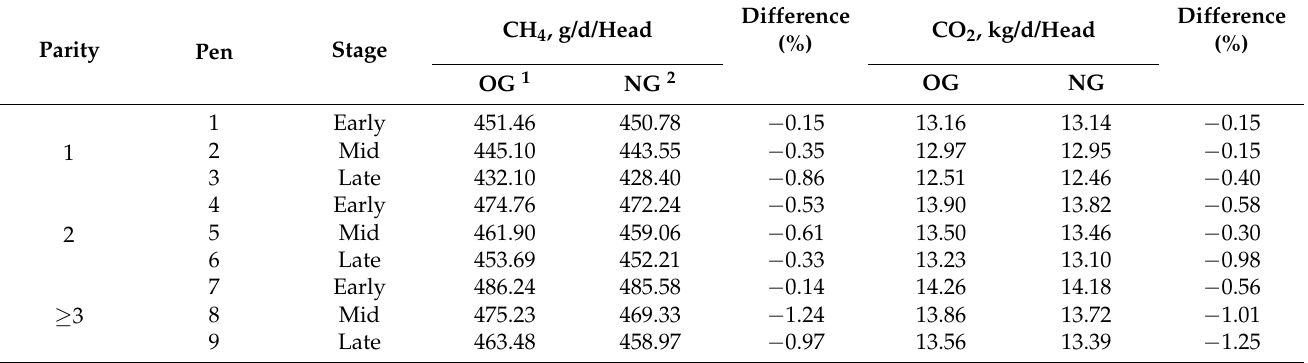
Table 7. Methane and carbon dioxide emissions from cattle for group and nutrient group